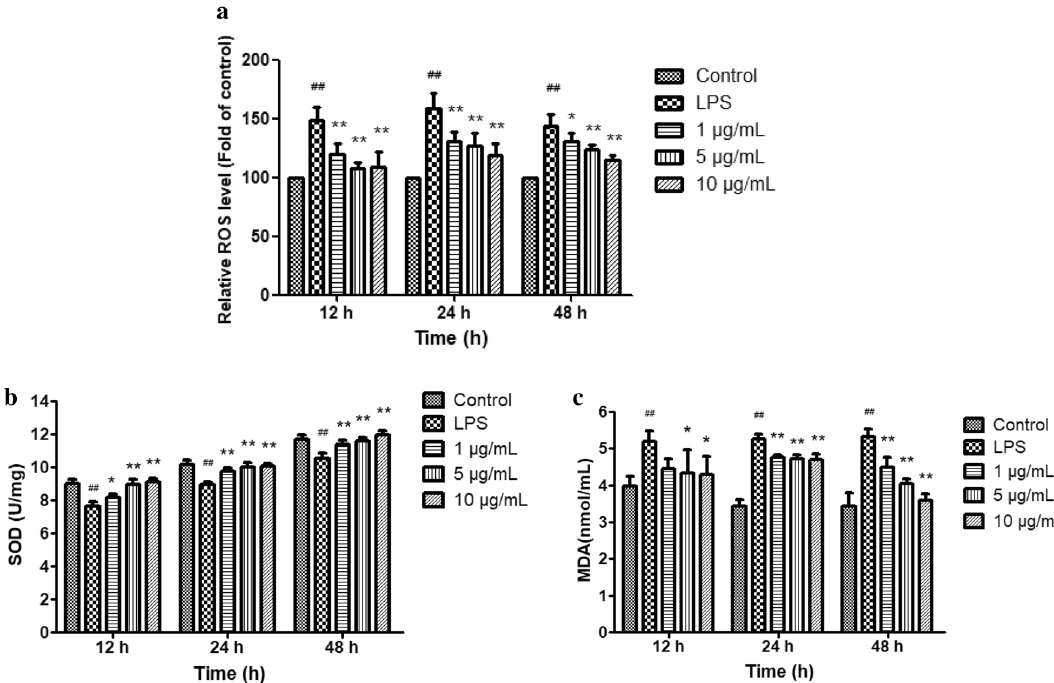
Figure 5. Effect of licochalcone A on LPS-induced levels of reactive oxygen species (ROS) ( a ), superoxide dismutase (SOD) ( b ) and malondiadehyde (MDA) ( c ) in claw dermal cells. Cells were exposed to gradient concentrations of licochalcone A (1, 5, 10 μg/mL) with or without the presence of 10 μg/mL LPS for 12, 24, and 48 h. The data were presented as mean ± SEM (n = 6). ## P < 0.01 vs. control group; * P < 0.05 vs. LPS model group; ** P < 0.01 vs. LPS model